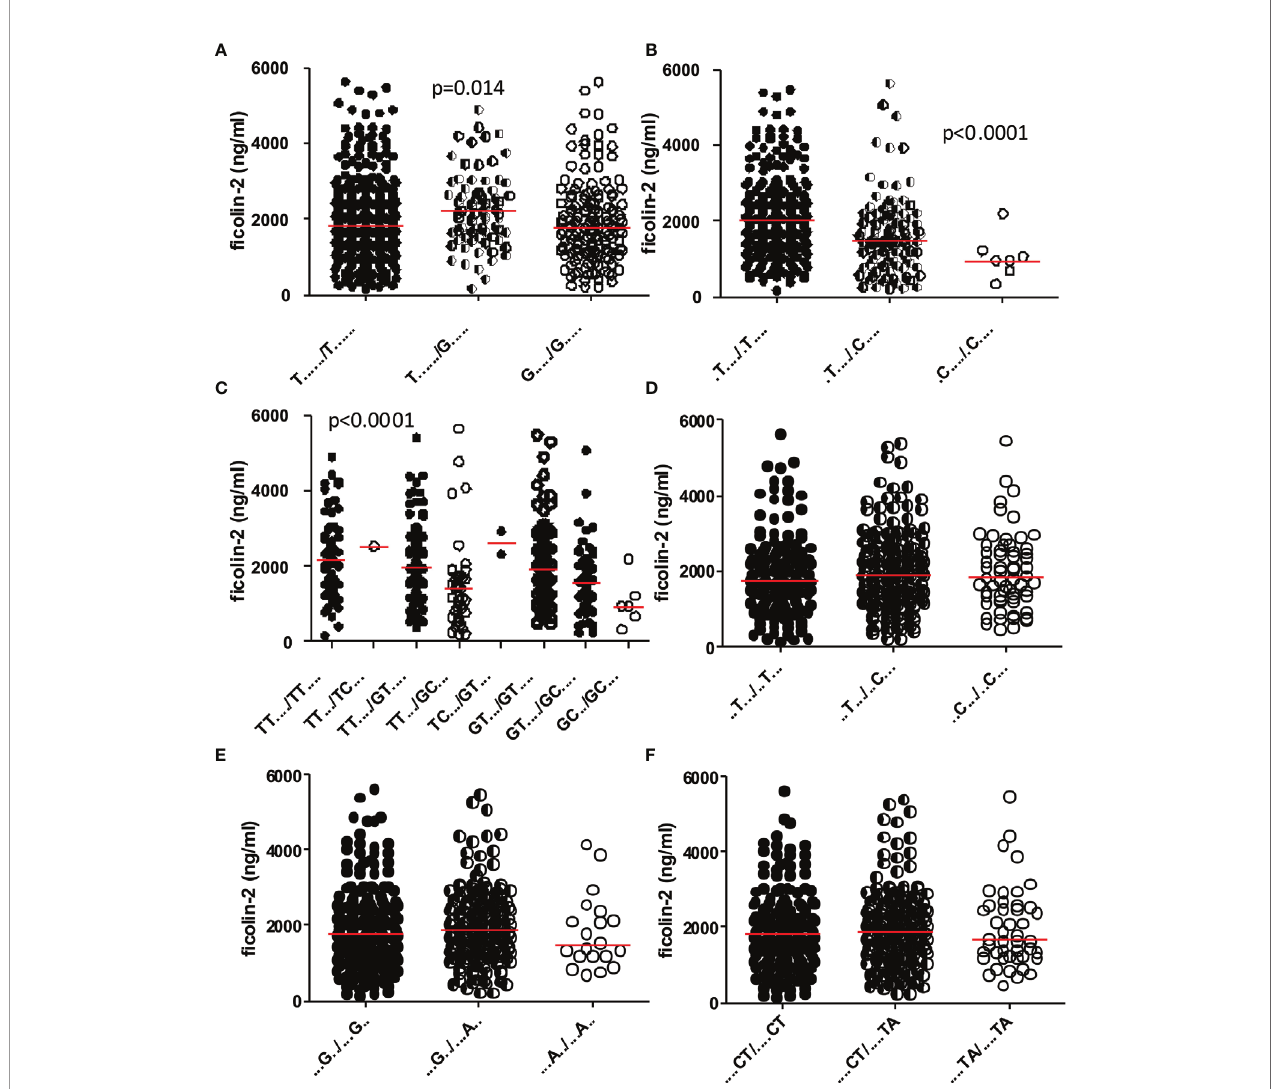
FIGURE 4 | The in fl uence of selected single nucleotide polymorphisms on fi colin-2 cord blood serum concentration in preterm neonates. Genetic variants: rs4521835 (A) , rs73664188 (B) , rs4521835 and rs73664188 (C) , rs11103564 (D) , rs11103565 (E) , rs6537958 and rs6537959 (F) . Medians are shown as red bars. Ficolin-2 concentrations among carriers of various genotypes were compared using Kruskal-Wallis